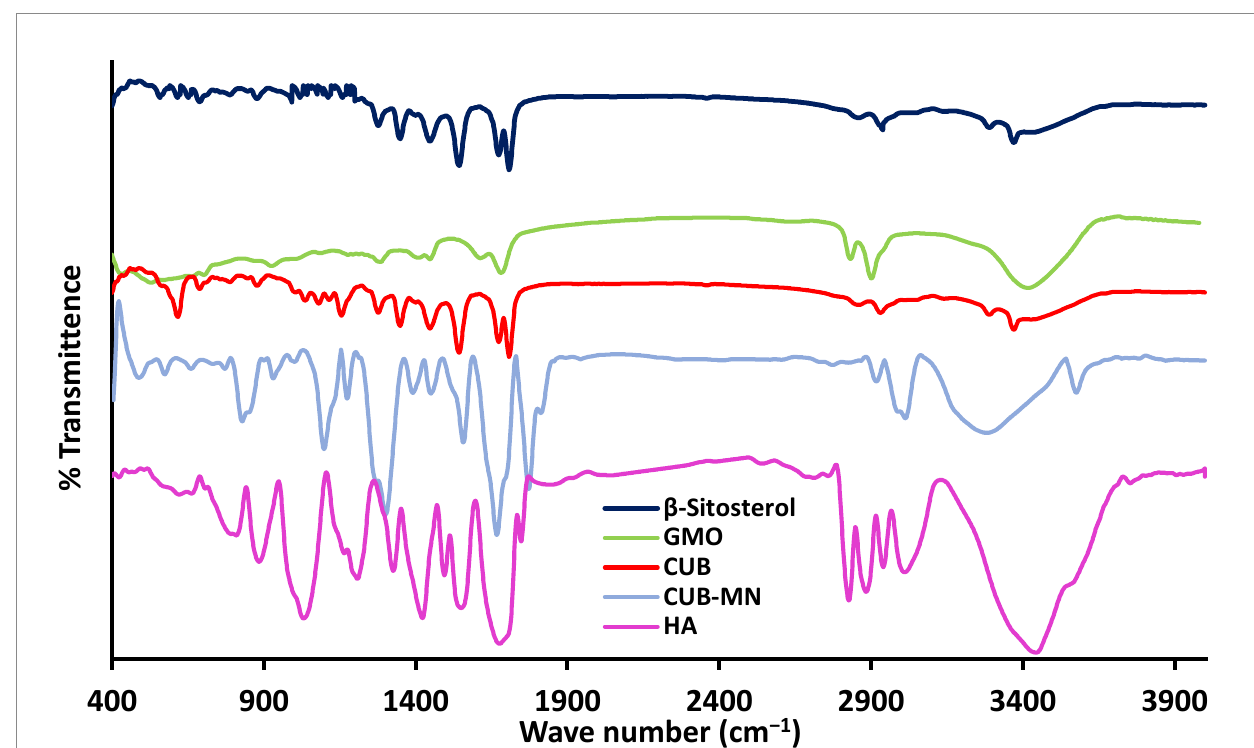
Figure 7. IR spectra of β - ST, GMO, HA, CUBs, and CUBs - MN D .